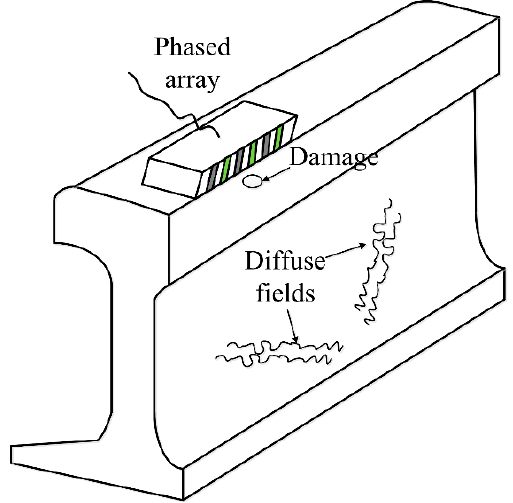
Figure 1. Schematic diagram of the data acquisition system.